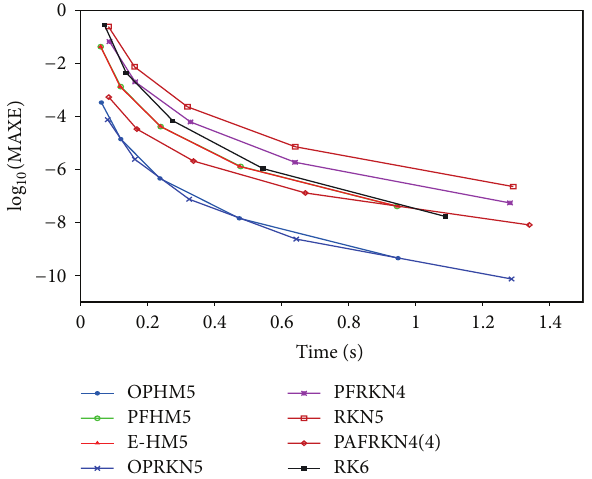
Figure 8: The efficiency curves of the optimized order six method and their comparisons for Problem 2 with 𝑡 = 2 𝑖 , 𝑖 = 1,...,5 . end